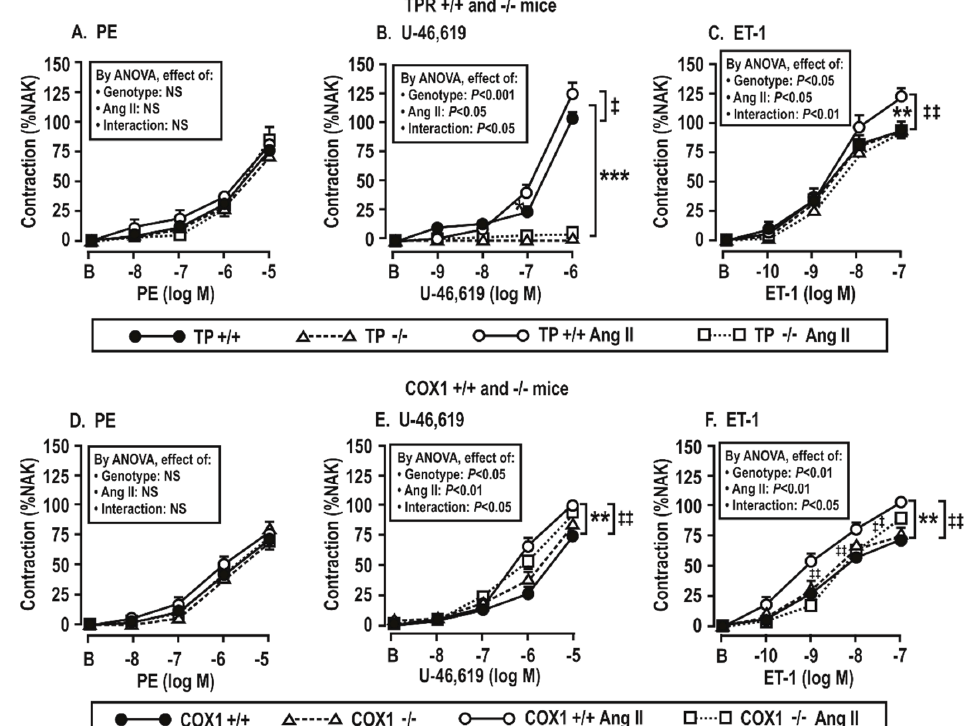
Figure 4. TPRs and COX1 are required for enhanced vascular contractions to U-46,619 ( B , E ) and endothelin 1 ( C , F ) but not to phenylephrine (PE, A , D ) in mesenteric resistance arterioles from mice infused with angiotensin II at 400 ng · kg − 1 · min − 1 × 14 days. Mean ± SEM values ( n = 6 per group). For vascular contractions in thromboxane prostanoid receptor (TPR) wild type ( +/+ ) and knockout ( − / − ) mouse vessels (upper panels) and COX 1 +/+ and − / − mouse vessels (lower panels). B, before; %NAK, compared to a standard vascular contraction with norepinephrine and high KCl. Compared to without angiotensin II infusion: *, P < 0.05; **, P < 0.01, ***, P < 0.005. Compared to +/+ mice: ‡‡ , P < 0.01; NS: P > 0.05 .